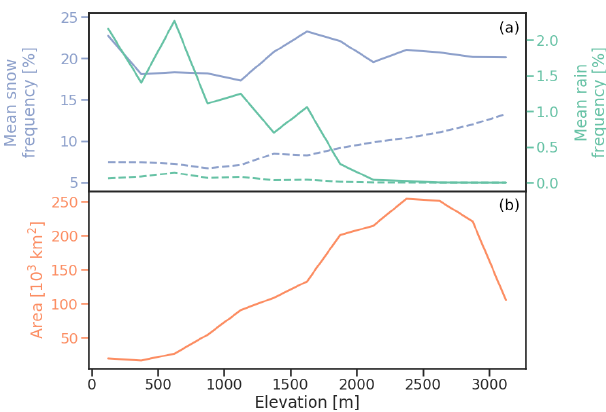
Figure 3. (a) CloudSat 2CPC (2006–2016 average) Greenland Ice Sheet snow and light snow (blue: solid, dashed) and rain and light rain (green: solid, dashed) frequency in 250m elevation bins based on Greenland Ice sheet Mapping Project (GIMP; Howat et al., 2014) topography. (b) Total ice sheet grid cell surface area in each of these elevation bins according to